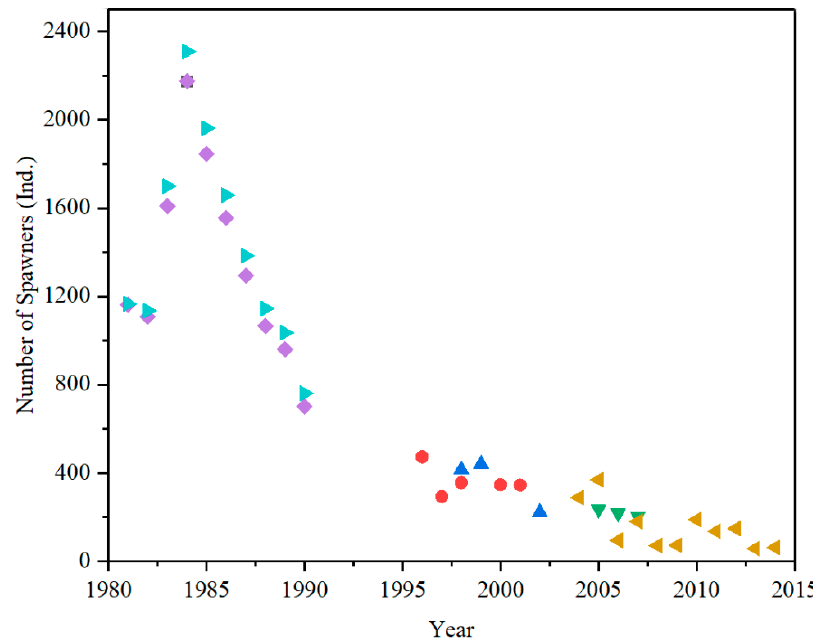
Figure 9. Temporal variations of adult CS population at the Gezhouba spawning site in the Yangtze River. Note: Blue square represents the data collected from Ke et al. [33], red dot from Wei et al. [34], blue triangle from Qiao et al. [35], green inverted triangle from Tao et al. [36], purple diamond from Huang et al. [37], left brown triangle from Wu et al. [38], right green triangle from Huang et al. [39].